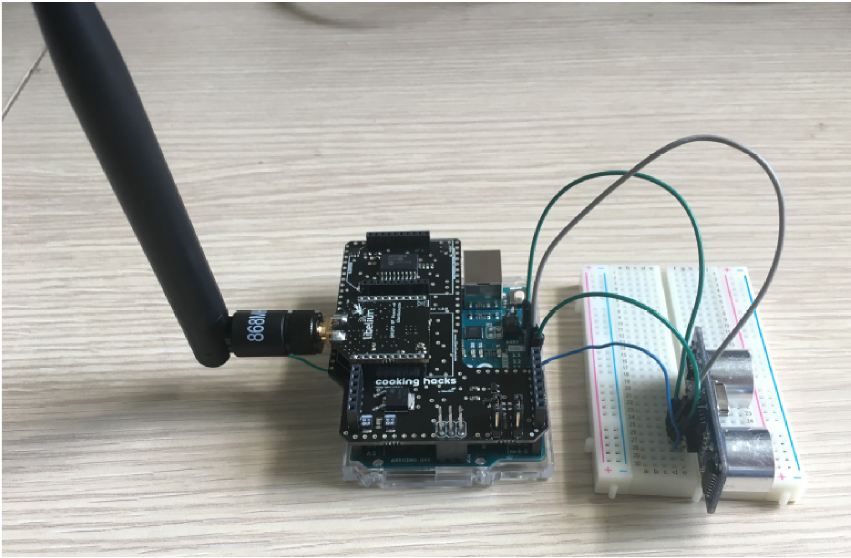
Figure 3. First prototype of the